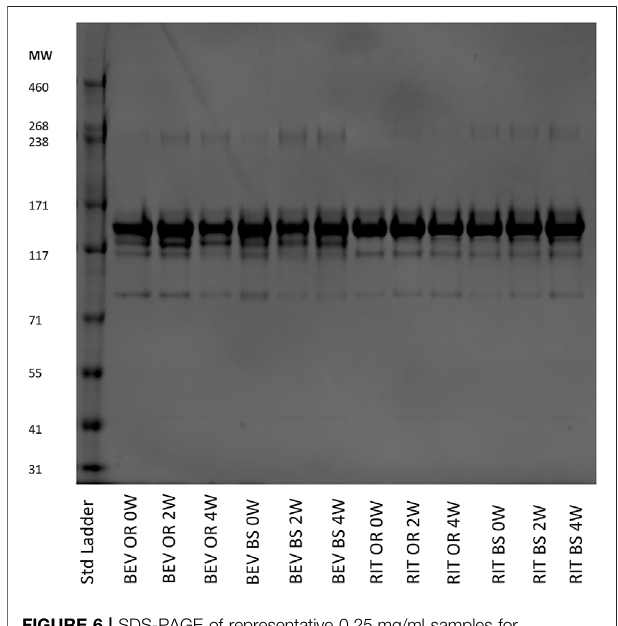
FIGURE 6 | SDS-PAGE of representative 0.25 mg/ml samples for bevacizumab OR and BS and rituximab OR and BS depicting the fragmentation and aggregation of the samples at each timepoint. Samples were incubated 0, 2 or 4 weeks at 37 ° C, shaking at 240